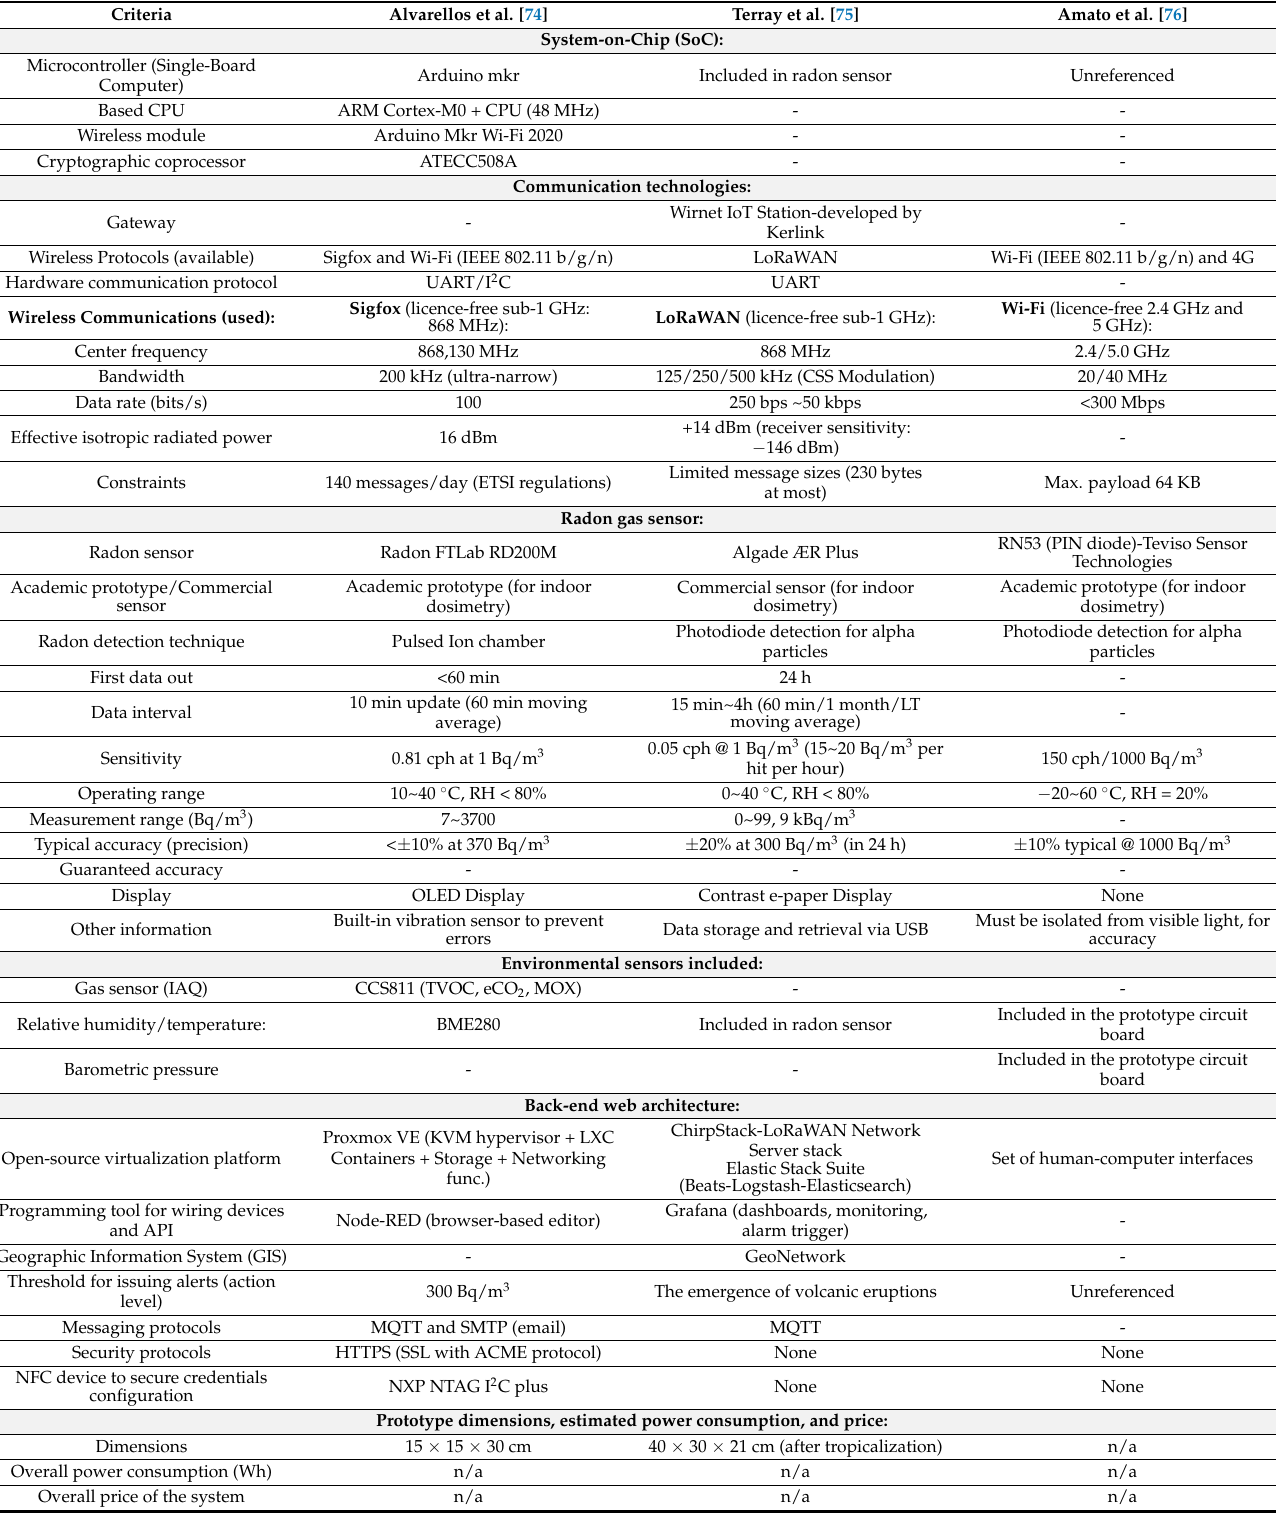
Table 5. Comparative study for radon monitoring